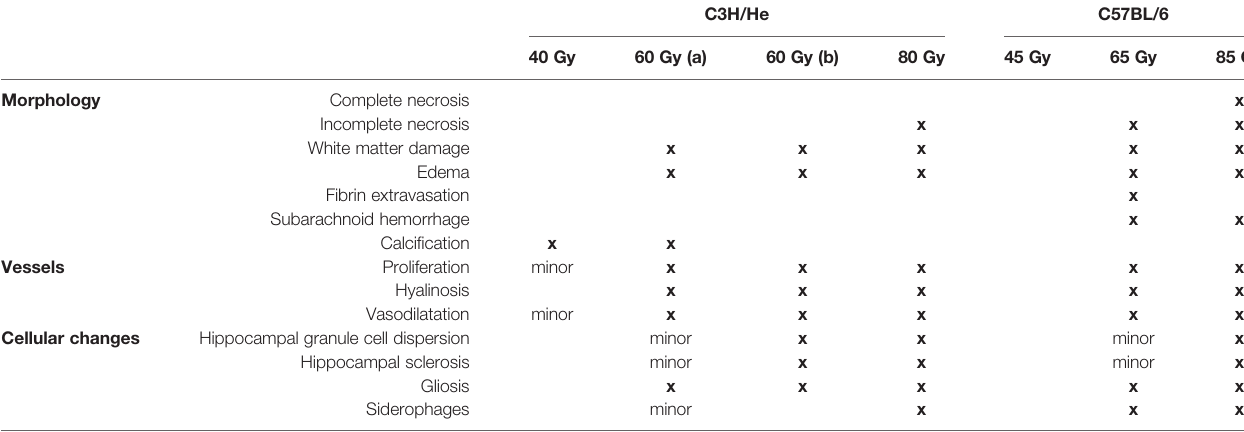
TABLE 2 | Overview of normal brain tissue toxicities observed after proton irradiation with different doses in C3H/He and C57BL/6.